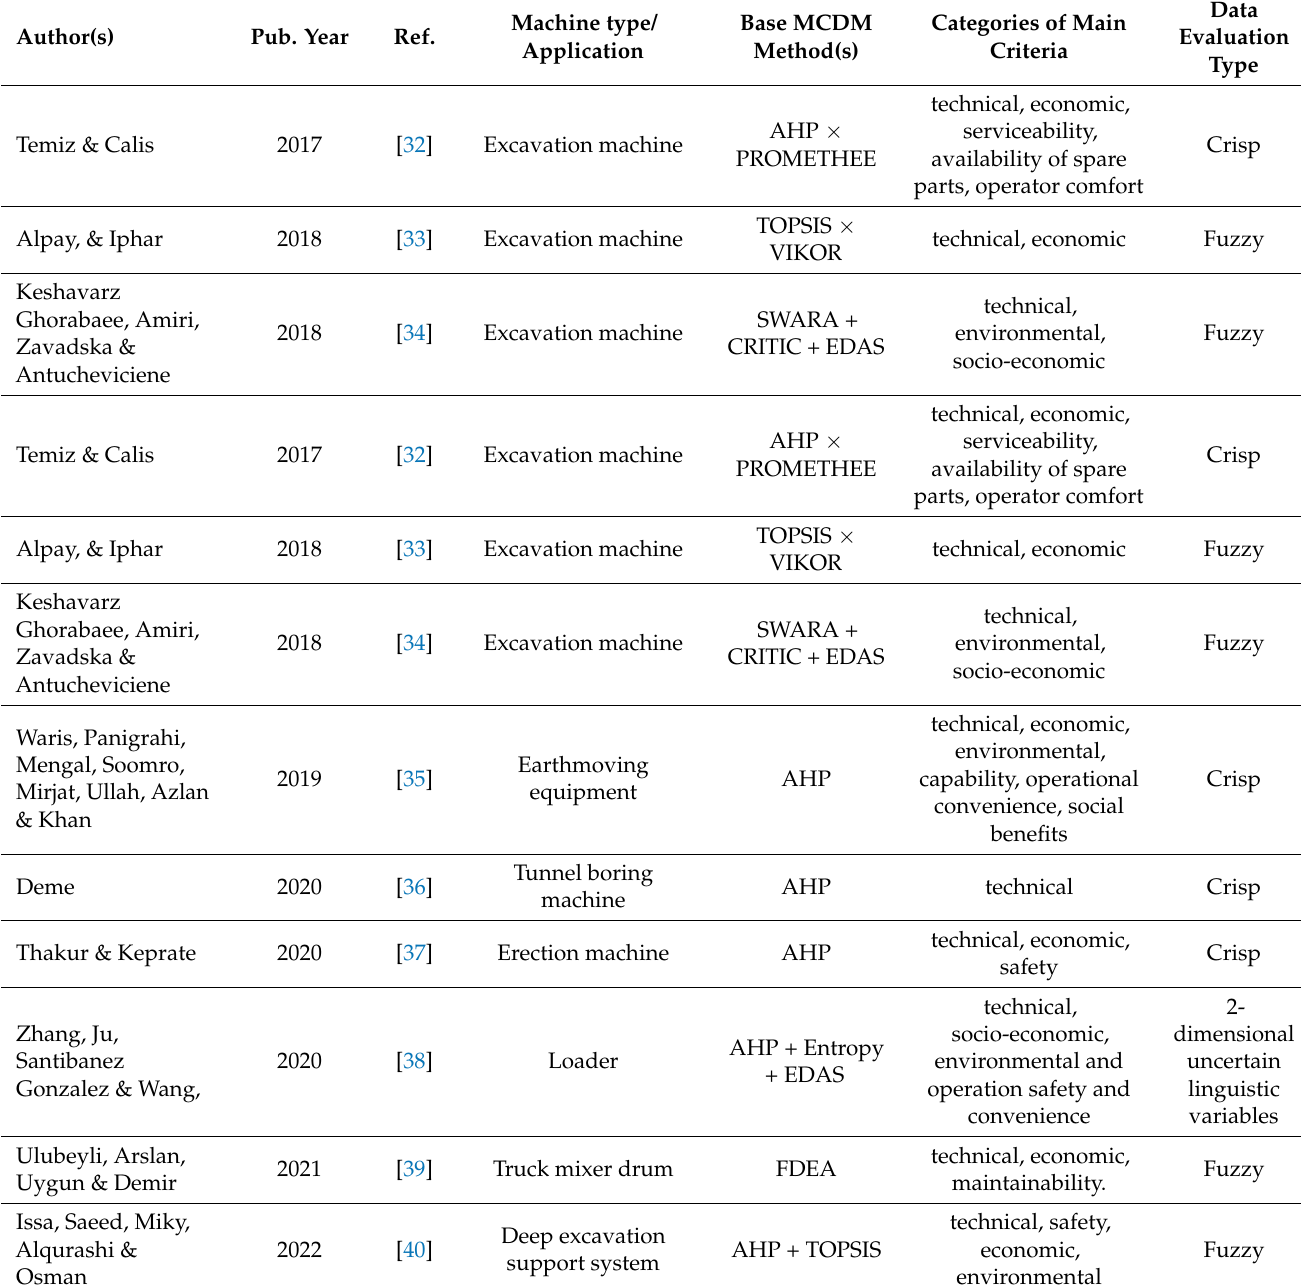
Table 3. Characteristics of surveyed papers in